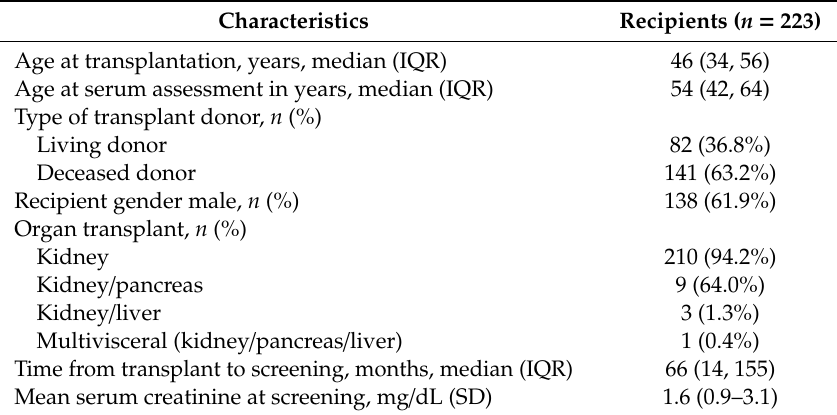
Table 1. Patient characteristics from outpatient